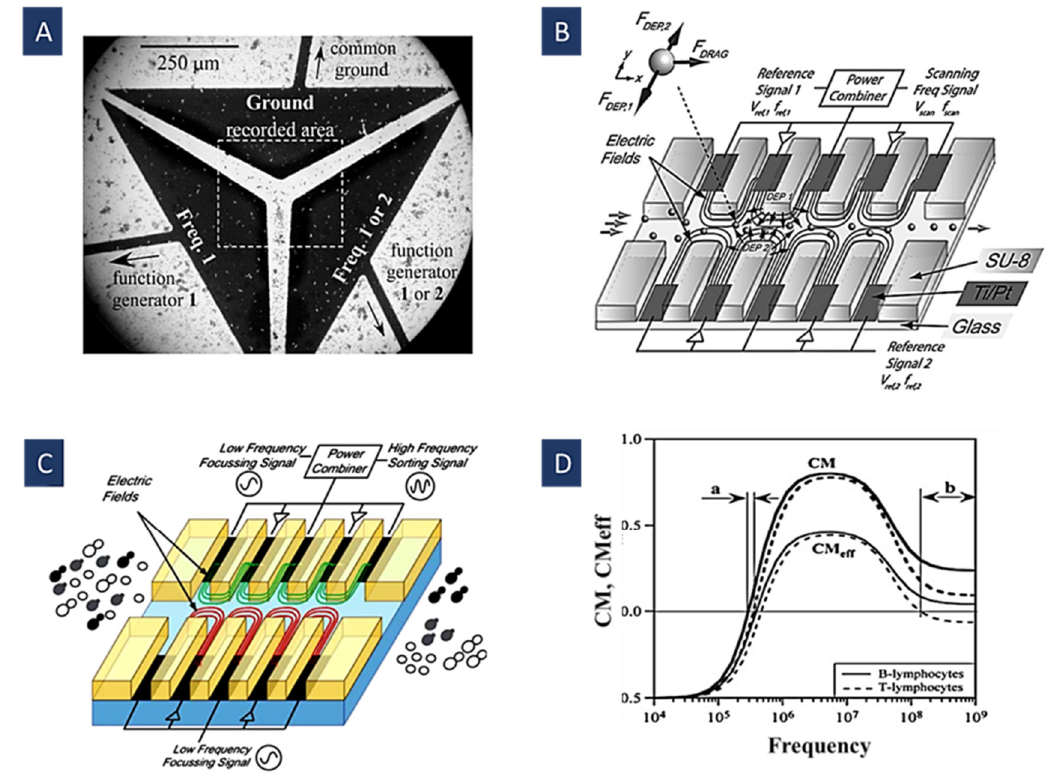
Figure 5. ( A ) Separation of live and dead yeast cells using their CM eff in multi-frequency DEP (Reprinted with permission from [66]. Copyright 2007, John Wiley and Sons); ( B ) focusing and separation of PS particles and yeast cells using different sets of potentials and frequencies (Reprinted with permission from [65]. Copyright 2008, Elsevier); ( C ) on-chip cell sorting using their characteristic equilibrium positions for different division stages of yeast cells (Reprinted with permission from [96]. Copyright 2011, Royal Society of Chemistry); ( D ) CM spectra for human T- and B-lymphocytes as a function of frequency with their CM eff after adding a 10-kHz signal with a relative amplitude of 0.6 to the original frequency. The isolation range is widened from a to b (Reprinted with permission from [66]. Copyright 2007, John Wiley and Sons).